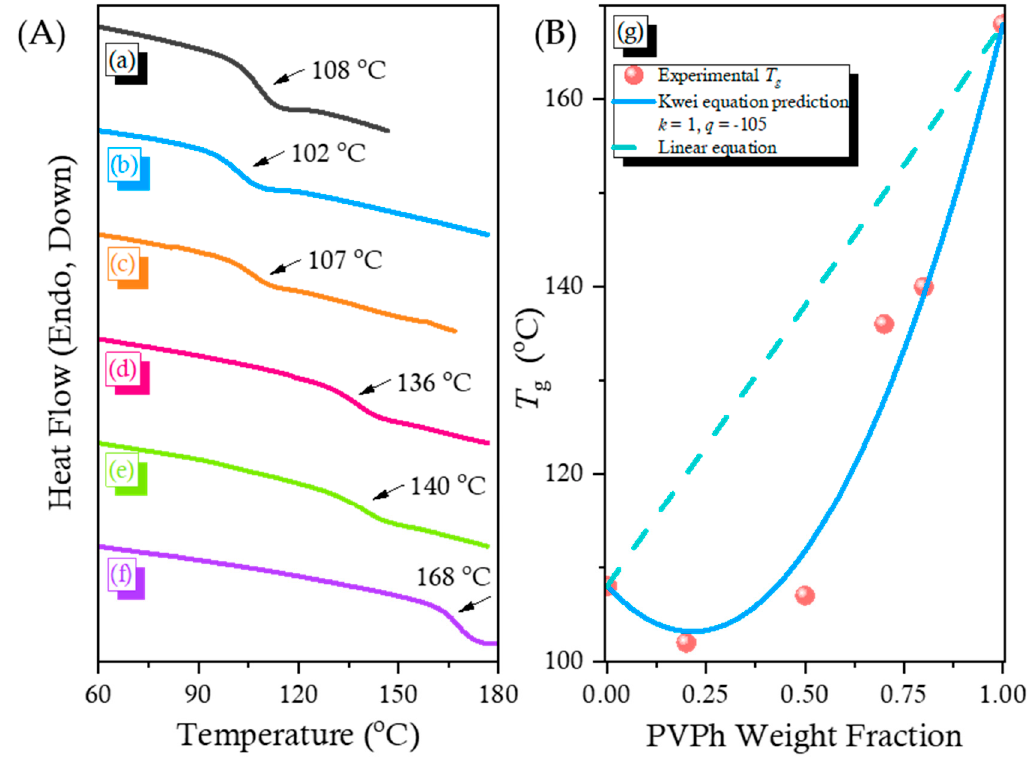
Figure 3. ( A ) DSC thermal analyses of PVPh/PCHC binary blends: ( a ) pure PCHC, ( b ) PCHC-80, ( c ) PCHC-50, ( d ) PCHC-30, ( e ) PCHC-20, and ( f ) pure PVPh; ( B ): (g) Corresponding values of T g predicted by the linear rule and the Kwei equation.